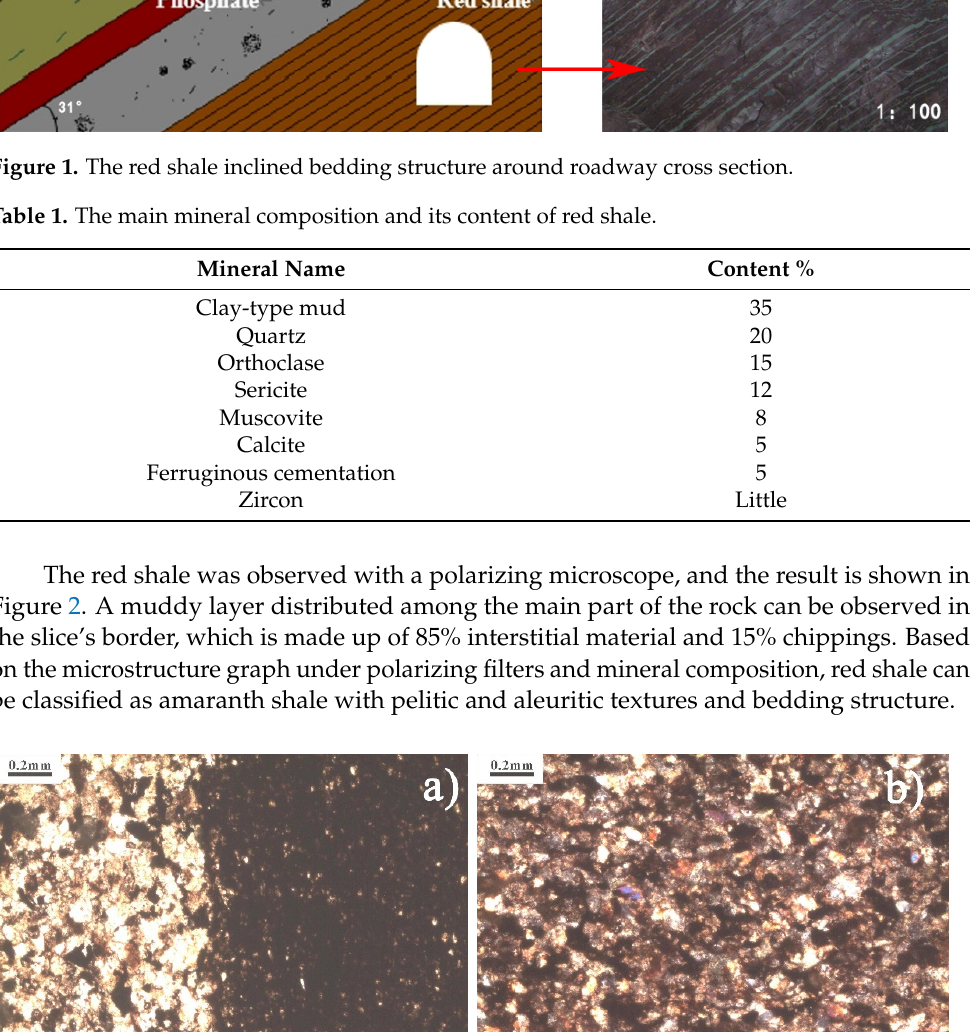
Figure 1. The red shale inclined bedding structure around roadway cross section.